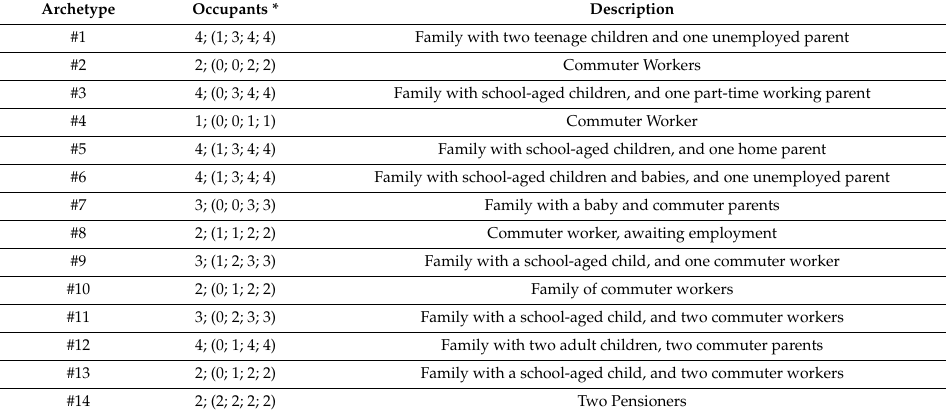
Table 3. Family composition of each